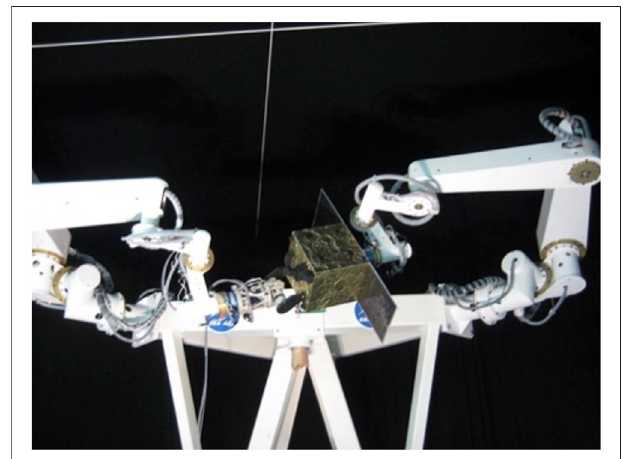
FIGURE 3 | Capture of a tumbling satellite on the CSA dual-arm simulator testbed